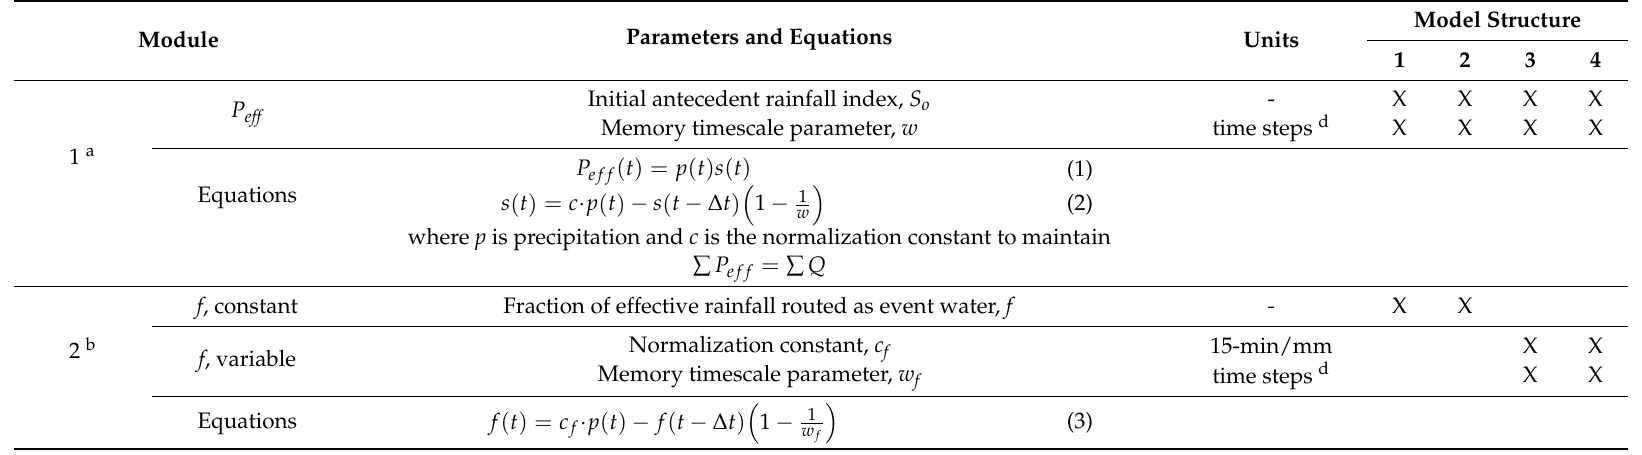
Table 1. Modules, equations, and parameters of the four Tracer-Based Streamflow Partitioning Analysis (TraSPAN) model